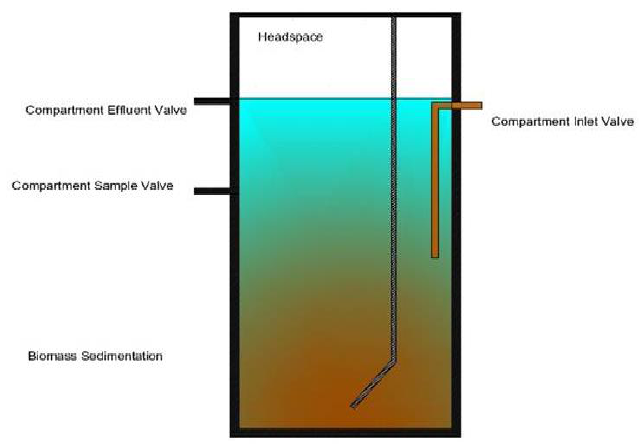
Figure 8. PABR compartment cut. Figure 8 . PABR compartment cut.